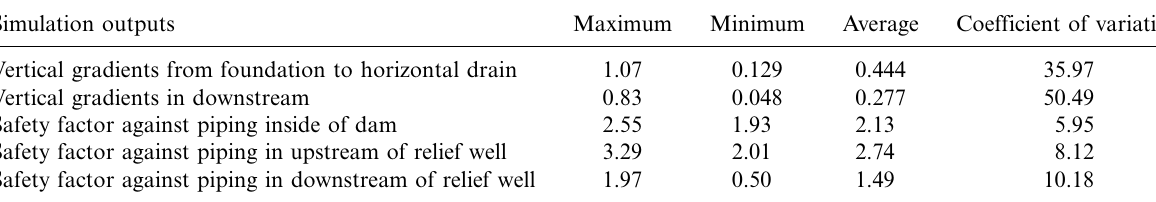
Table 6. Monte Carlo finite difference simulation for the second scenario Simulation